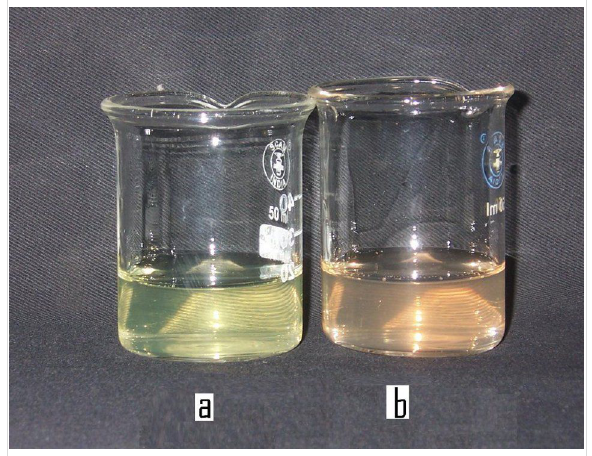
Figure 1: CdSe sols of different colors, synthesized by the reaction of (a) 2 × 10 − 3 mol dm − 3 Cd(AcO) 2 and 1 × 10 − 3 mol dm − 3 Na 2 SeSO 3 , and (b) 2 × 10 − 3 mol dm − 3 Cd(AcO) 2 and 4 × 10 − 3 mol dm − 3 Na 2 SeSO 3 , in the presence of 9.2% PVA, at 27